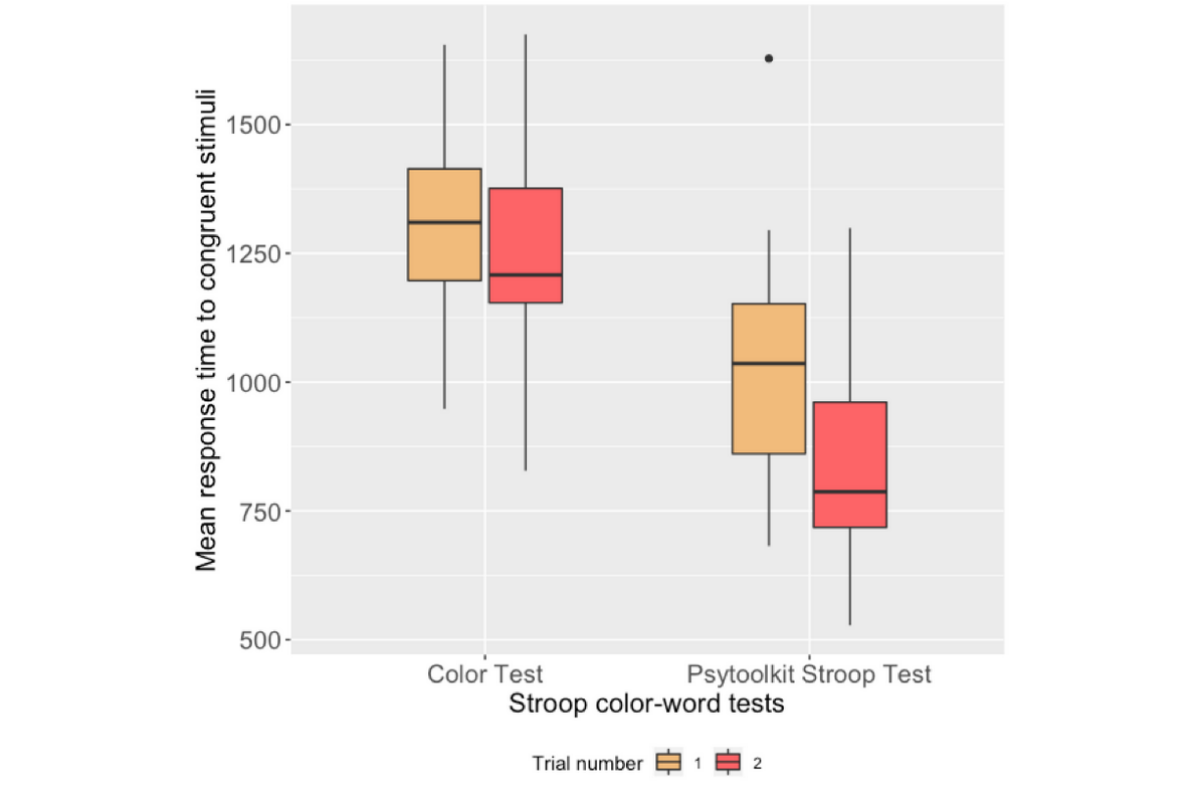
Figure 10. Box plots of participants' mean response times to congruent stimuli during Stroop tests.